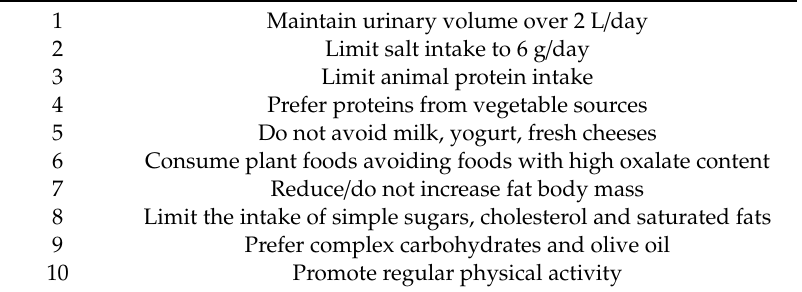
Table 2. A Decalogue for general healthy counseling in calcium stone